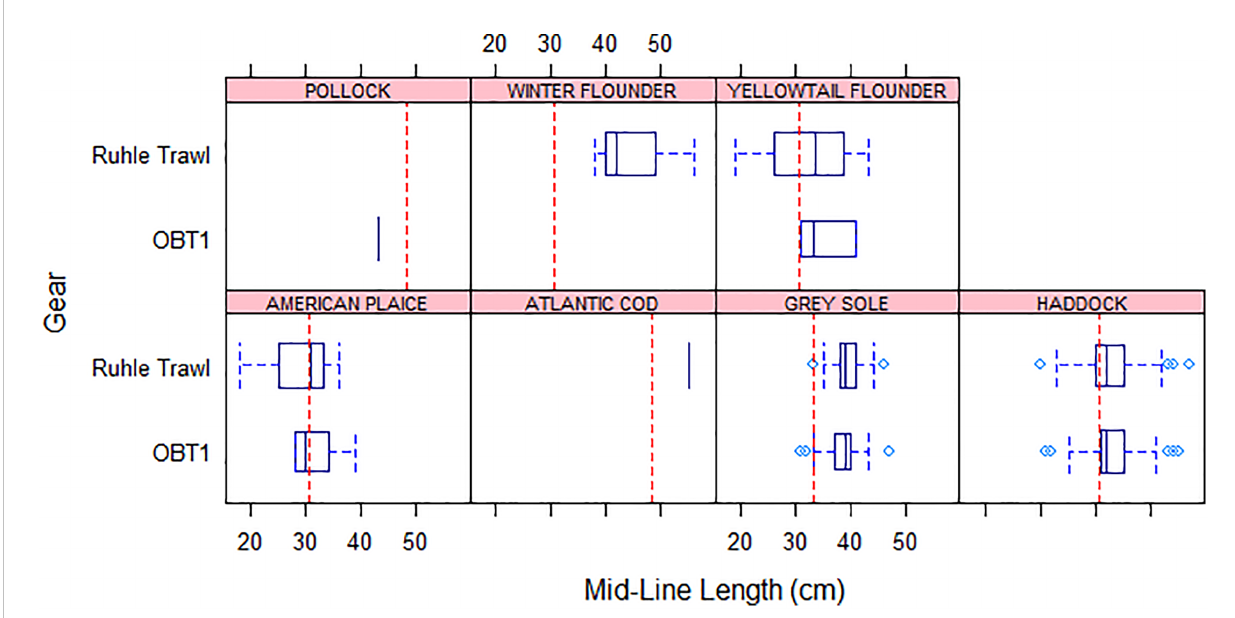
FIGURE 10 Mid-line lengths (x-axis) of species (panel) by gear type (y-axis) for trip 2. The red line is the minimum legal size for each species. Box widths represent the sample sizes within gear type.